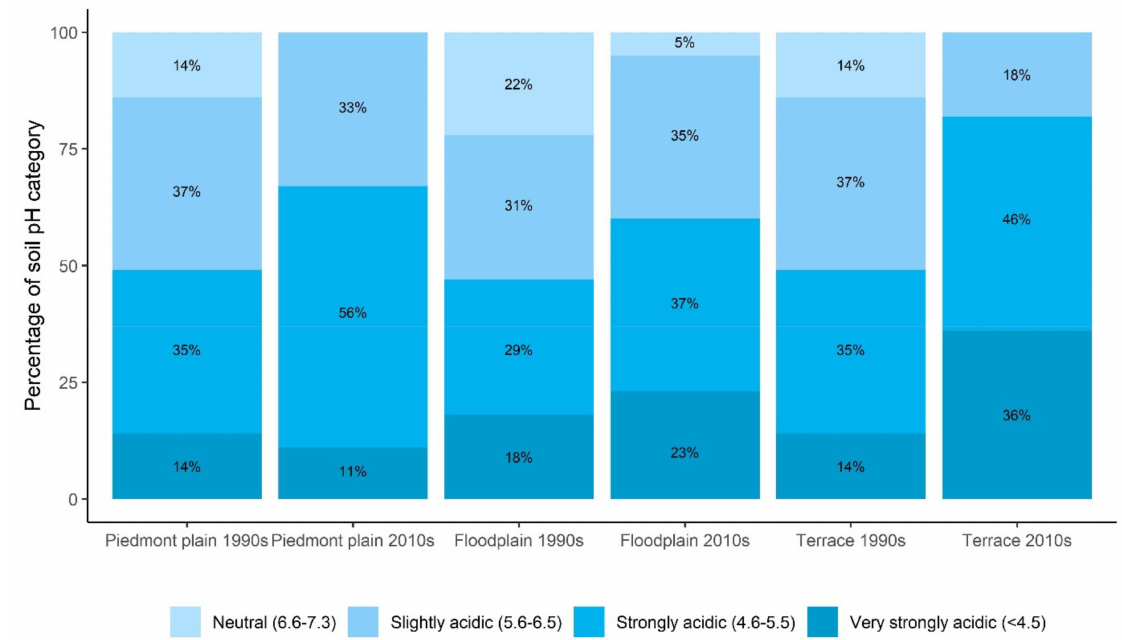
Figure 9. Percentage of soil pH (0–15 cm) category in legacy soil samples collected in the 1990s and 2010s in three physiogra- phy. The legend consists of the pH categories [33] in Bangladesh.